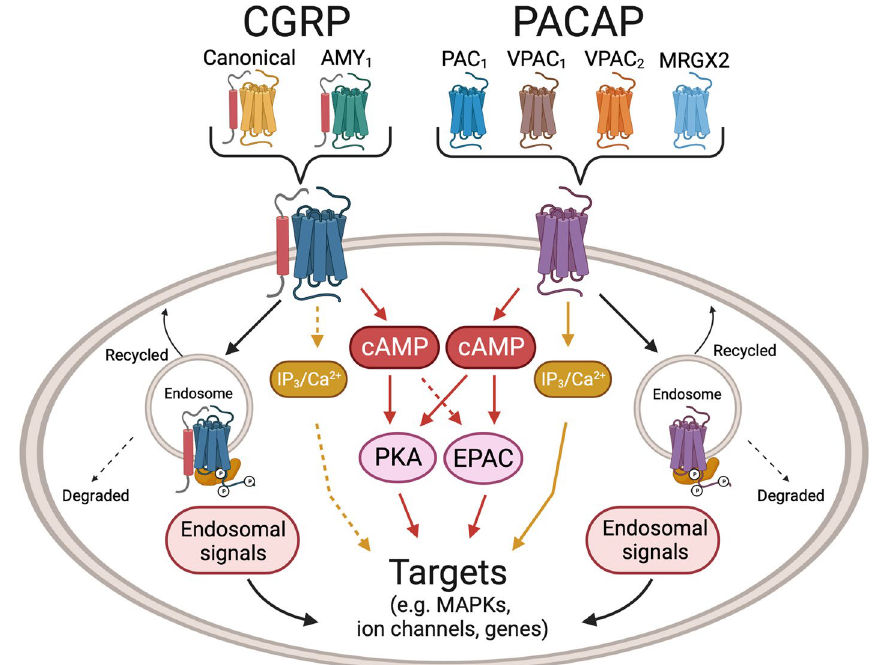
Fig. 3 Schematic of CGRP and PACAP signaling pathways. CGRP and PACAP can act via multiple receptors, as indicated. For simplicity, signaling pathways from generic receptors in a generic cell type are illustrated. In general, activation of both CGRP and PACAP receptors increase cAMP levels, which leads to protein kinase A (PKA) activation and EPAC1/2 activation. EPAC1/2 activation by PACAP is well-established, although activation by CGRP is less clear (dotted line). Canonical CGRP receptor, but not AMY 1 CGRP receptor, and the PACAP receptor PAC 1 can generate endosomal signals following β-arrestin-mediated receptor internalization. Activation of additional G protein pathways that elevate IP 3 and calcium have been reported for PACAP and to a lesser extent CGRP (dotted lines). These pathways activate multiple downstream targets, including MAP kinases (MAPKs), ion channels, and genes, depending on the cell type. Created with